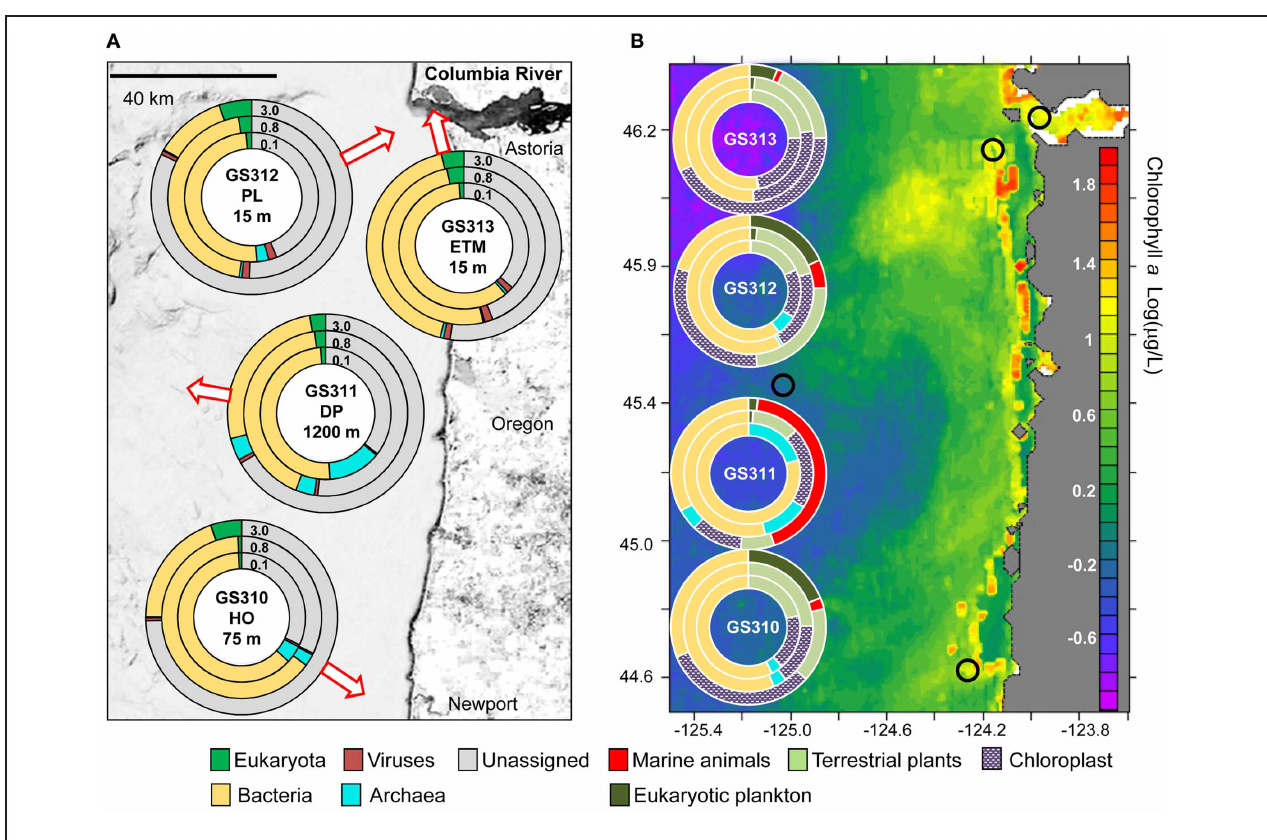
post-QC reads. (B) Domain abundance was calculated from SSU rRNA composition (% of total number of SSU rRNA reads). Small black circles indicate sampling locations mapped upon surface chlorophyll a Log( μ g/L) in the northeastern Pacific coastal ocean southward from the Columbia River mouth (NOAA satellite data averaged over a period of 14 days centered around Aug 23,